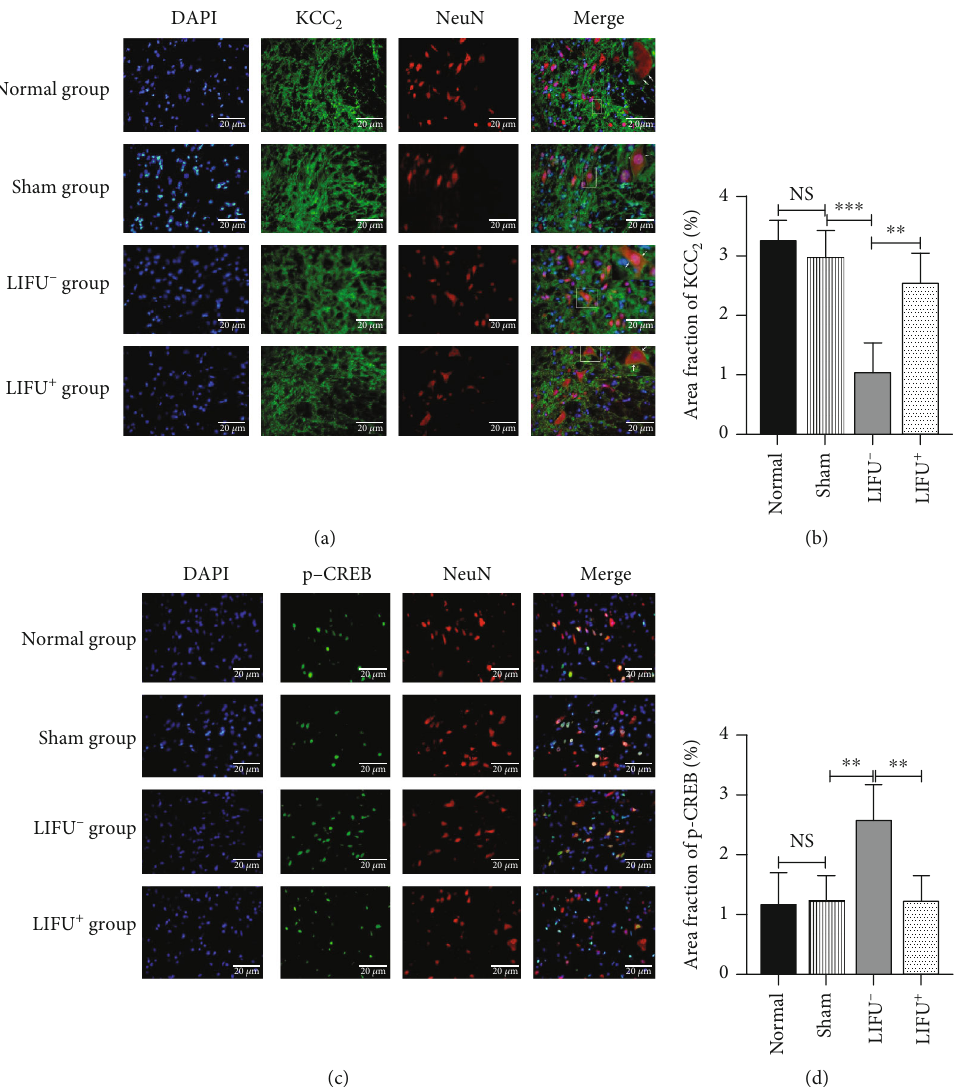
Figure 5: Expression of KCC (a) p-CREB (c) in the spinal cords of rats in di ff erent groups (IF, × 400). Scale bar = 20 μ m . Intensities of KCC 2 (b) and p-CREB (d) IF in the spinal cords of rats in di ff erent groups after 4 weeks of LIFU treatment. Each symbol represents the mean ± SEM ; ∗ P < 0 : 05 , ∗∗ P < 0 : 01 , ∗∗∗ P < 0 : 001 . One-way ANOVA; n = 5 rats per